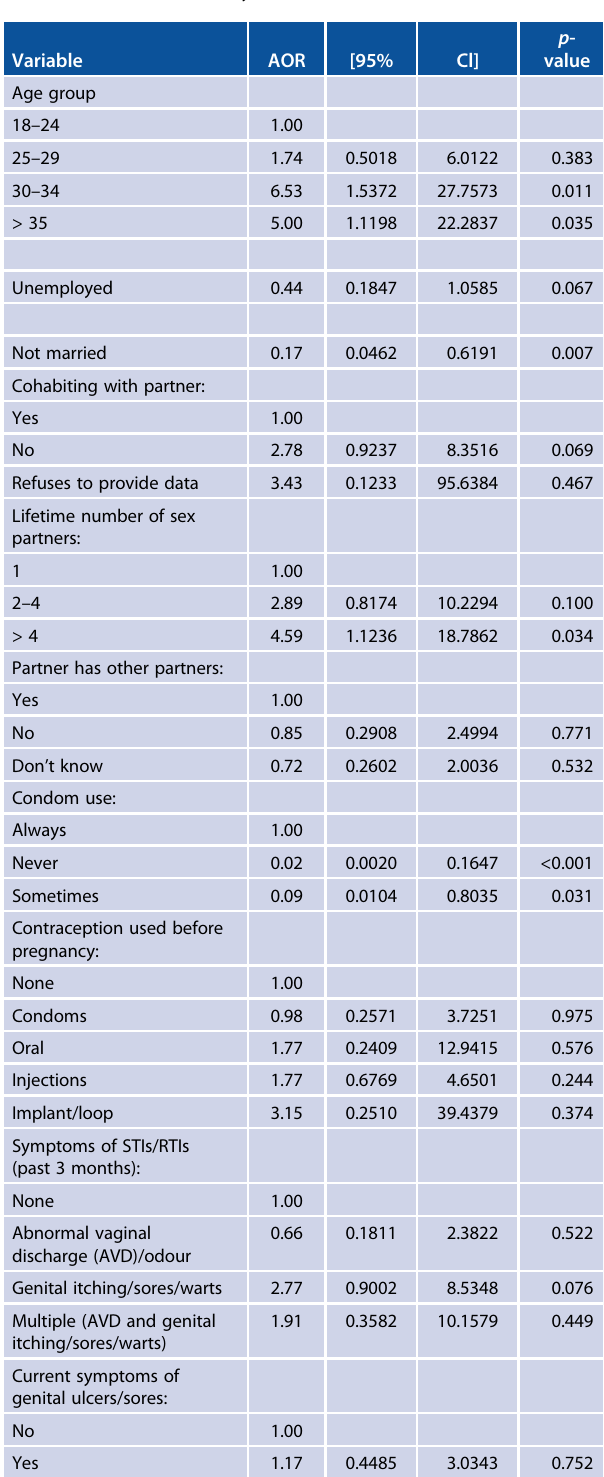
Table 3: Risk factors for HSV-2 and HIV-1 co-infections in the pregnant women enrolled in this study